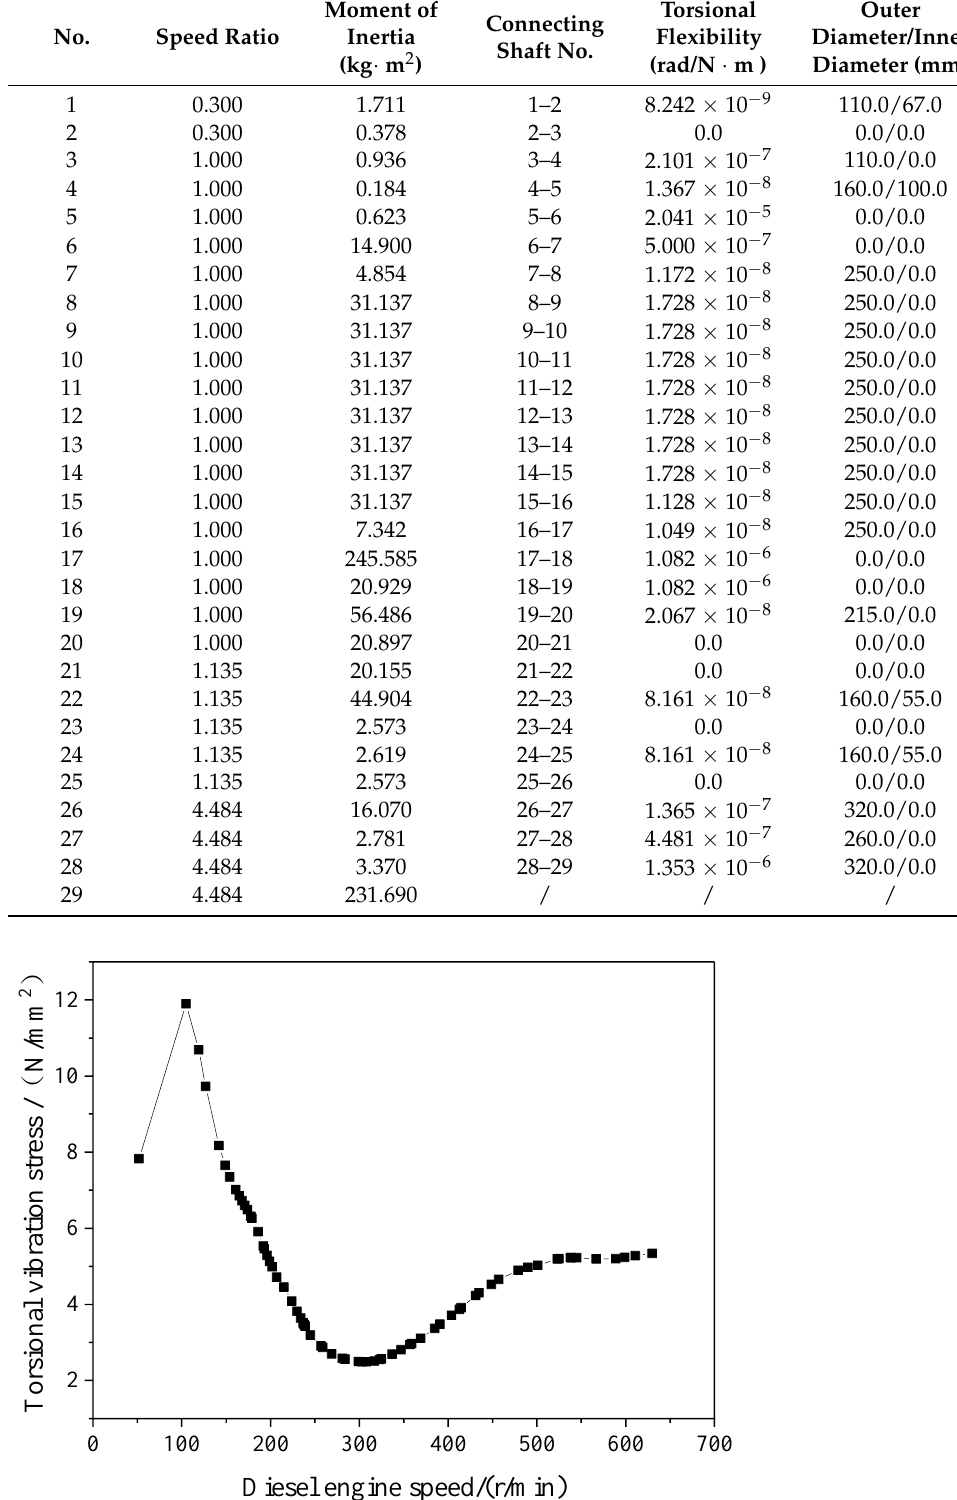
Figure 3. Torsional vibration stress change of intermediate shaft with diesel engine speed. It can be seen from torsional vibration stress change of intermediate shaft with diesel engine speed in Figure 3. Under the normal ignition condition of the diesel engine, in the speed range of 220 – 525 r/min, the torsional vibration stress of the intermediate shaft first decreases and then increases with the increase in the diesel engine speed, and the maxi- mum value of the torsional vibration stress is 5.199 𝑁/𝑚𝑚 2 .